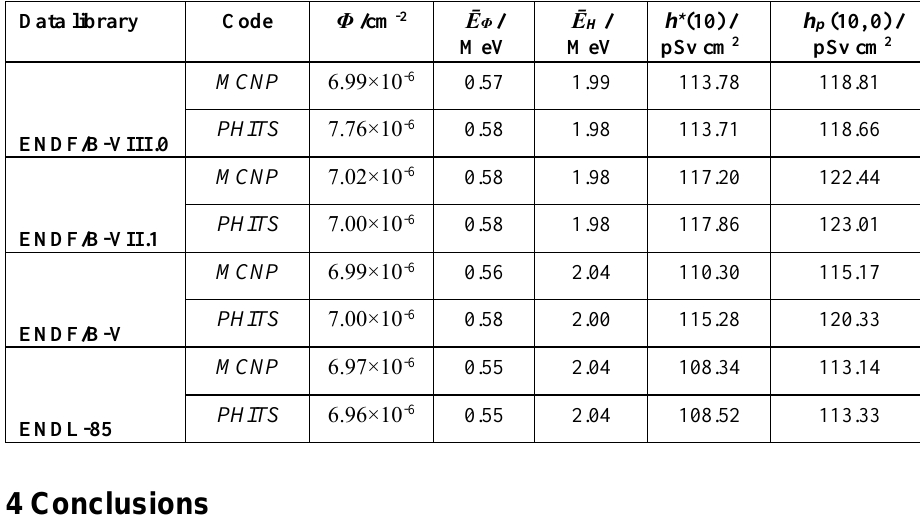
Table 1. The fluence rate ( Φ ), fluence-average energy ( Ē Φ ), ambient dose-average ( Ē H ), ambient h * (10) and personal h p (10, 0) conversion coefficient at 100 cm from the source, variation with cross section data libraries for the D 2 O- 252 Cf assembly of PTB using the codes MCNP6 and PHITS. The relative uncertainty in the fluence rate and dose quantities was below 0.07